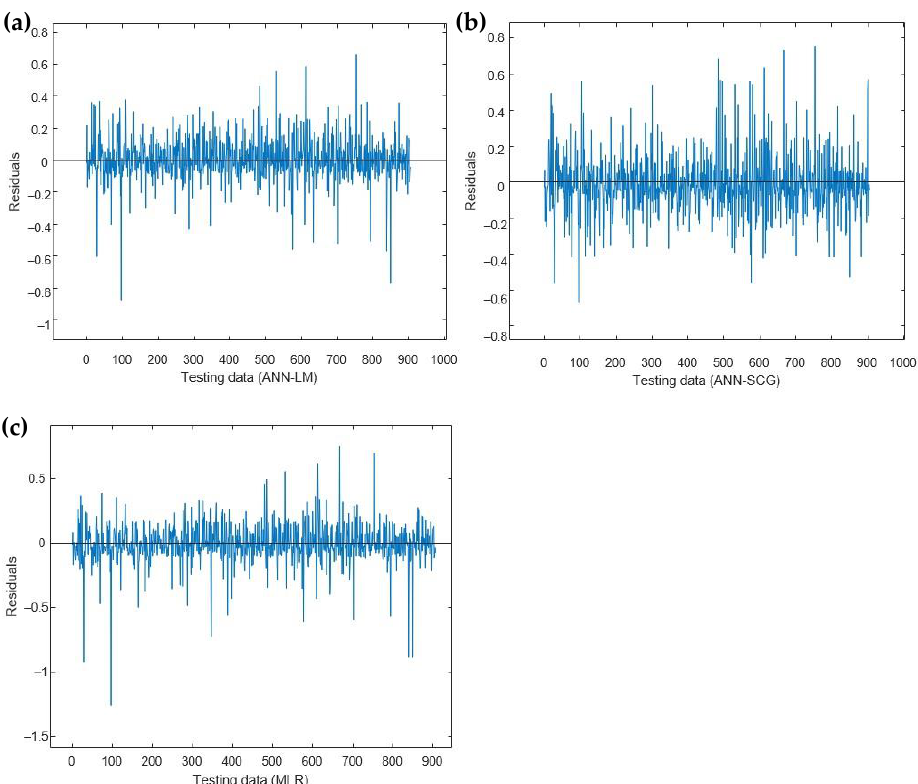
Figure 8. Residual comparison among ( a ) ANN-LM, ( b ) ANN-SCG, ( c ) MLR with the actual value of the concentration of H 2 S in sweet gas.